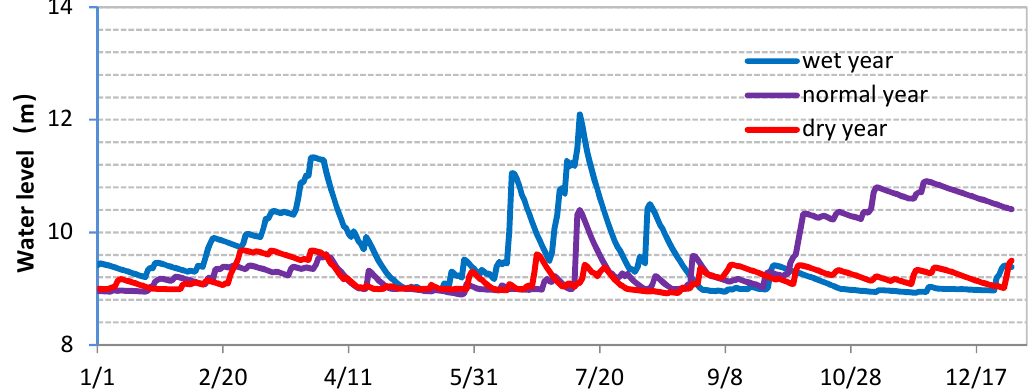
Figure 6. The water level variation of Gucheng Lake under optimal scheduling in wet, normal and dry years.